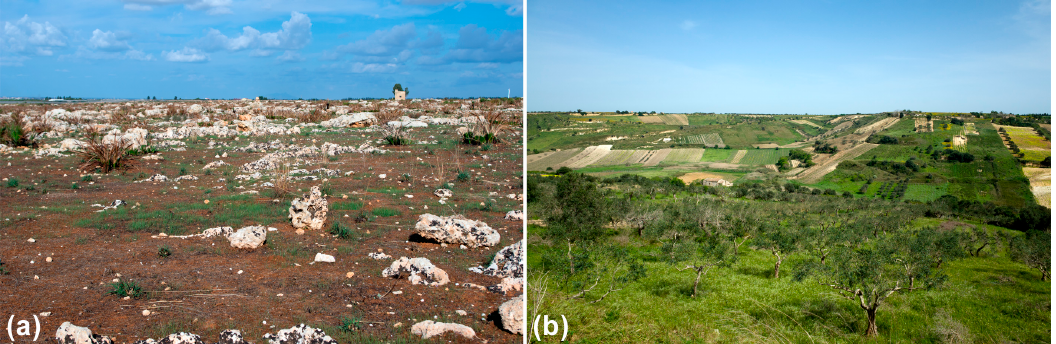
Figure 6. ( a ) The sciara di Mazara del Vallo; ( b ) land fragmentation resulting from the subdivision of parcels and agricultural diversity. Photographs: C. Sevara.